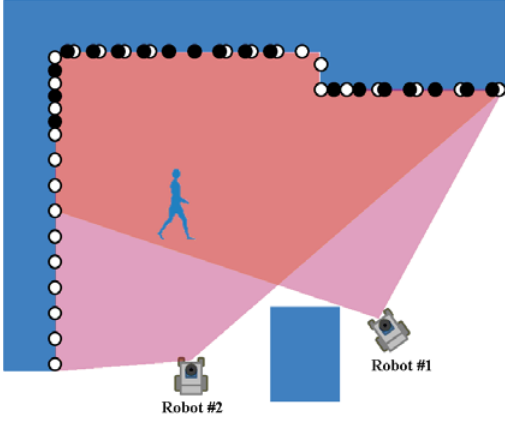
Figure 6. Robot localization by relative-scan matching; the solid and open circles indicate images scanned by robots #1 and #2,